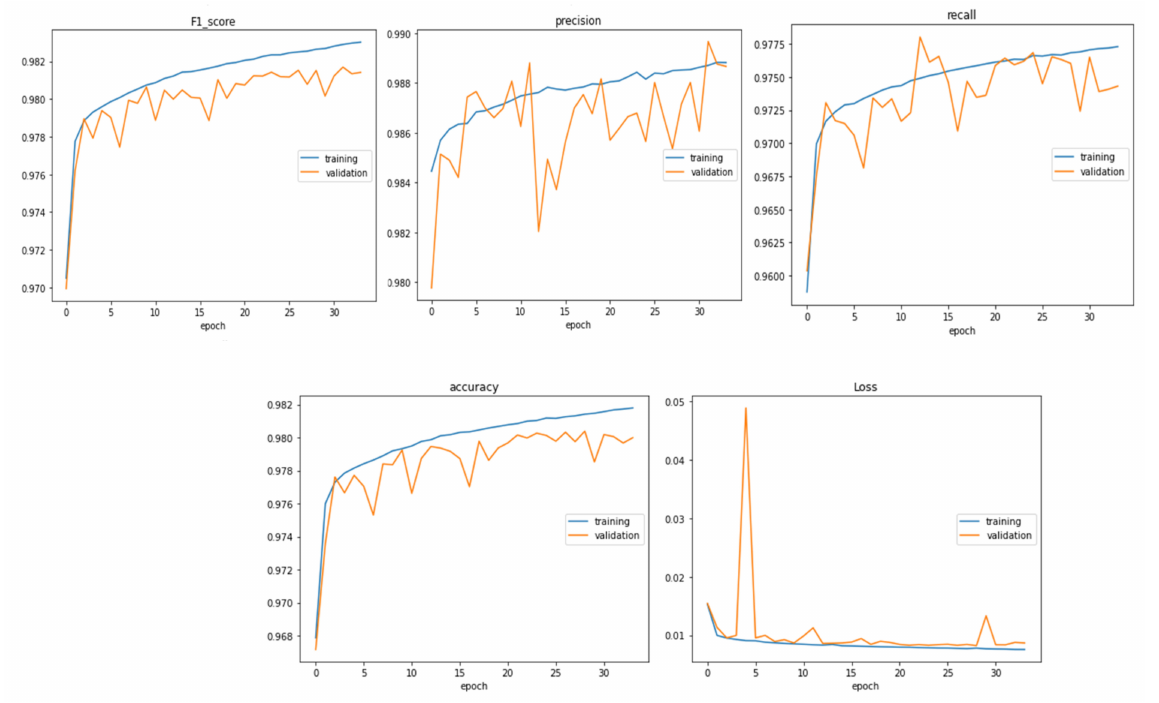
Figure 16. The training and validation accuracy, F1-score, loss, recall, and precision after training the Inception Time model using the UNSW-NB15 dataset.